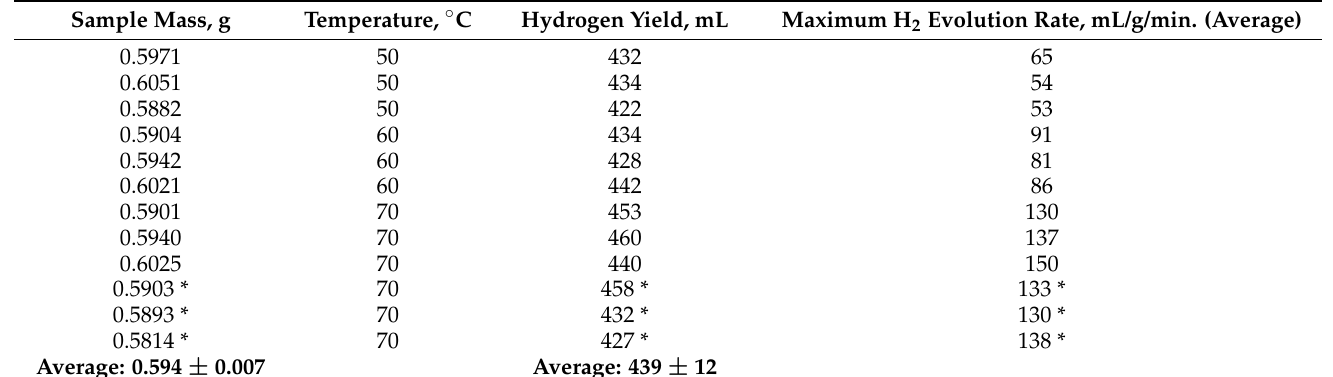
Table 3. Lid masses, hydrogen yields, and maximum evolution rates.